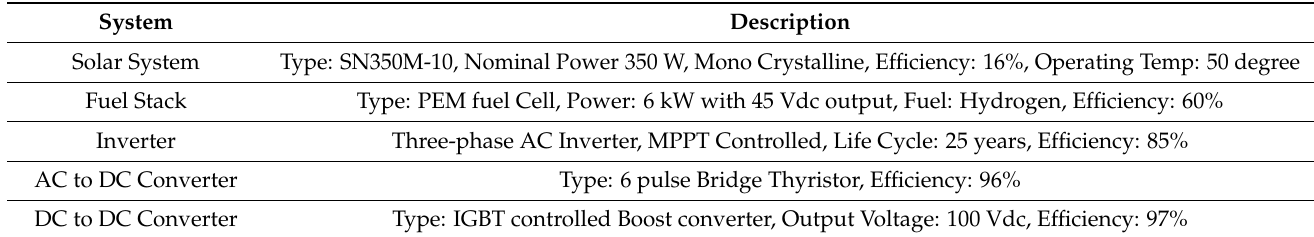
Table 1. Sustainable Sources Specifications.